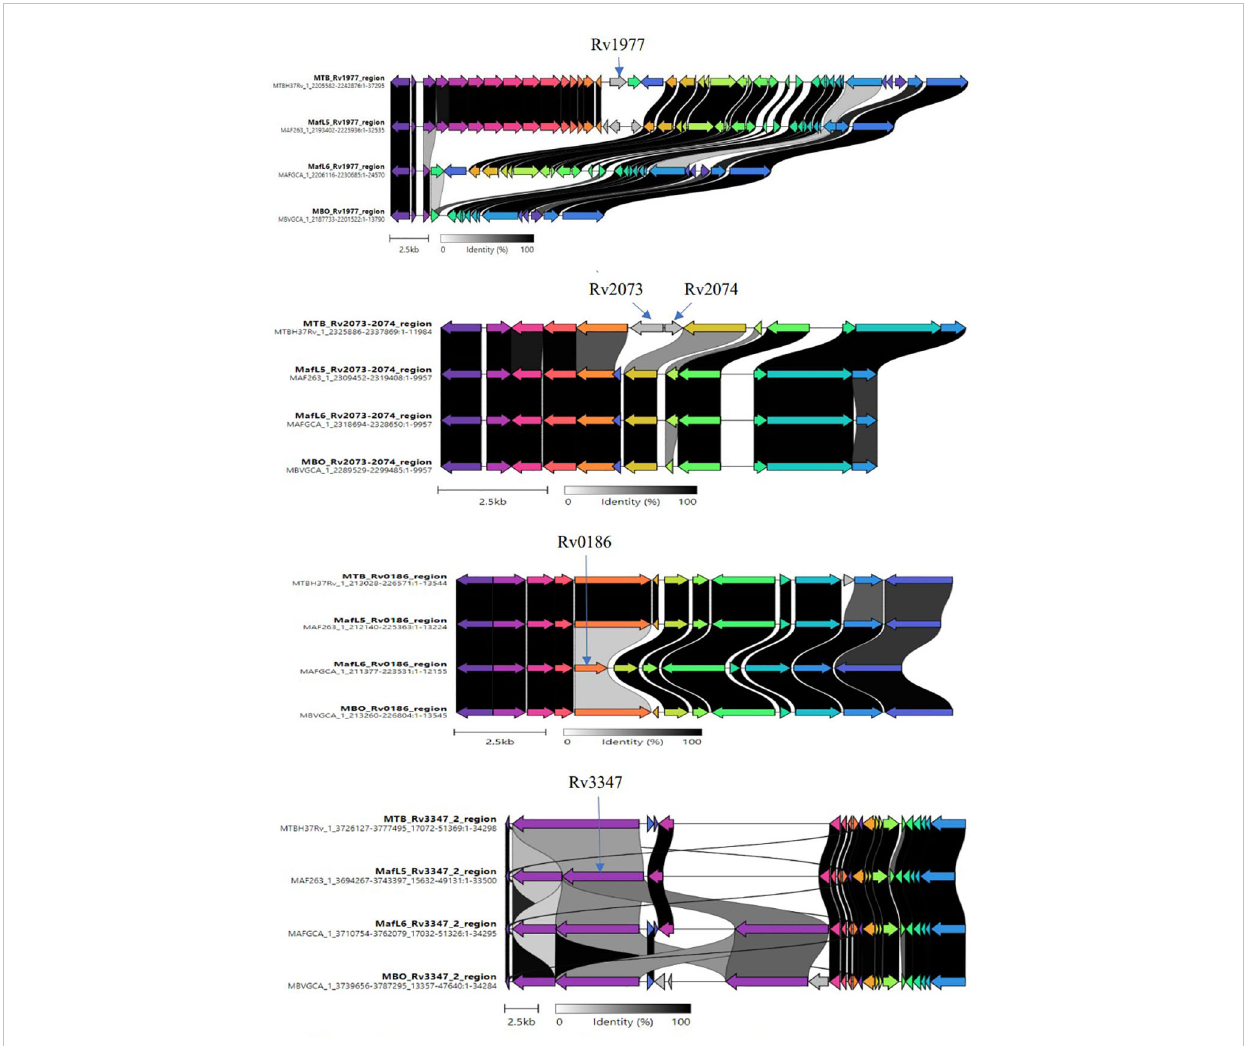
FIGURE 3 Clinker showing variations of lineage-speci fi c genes via alignment of gene clusters. Variable regions of the identi fi ed unique genes were examined through the alignment of gene clusters from members of the MTBC ( M. tuberculosis, M. africanum L5/L6 , M. bovis